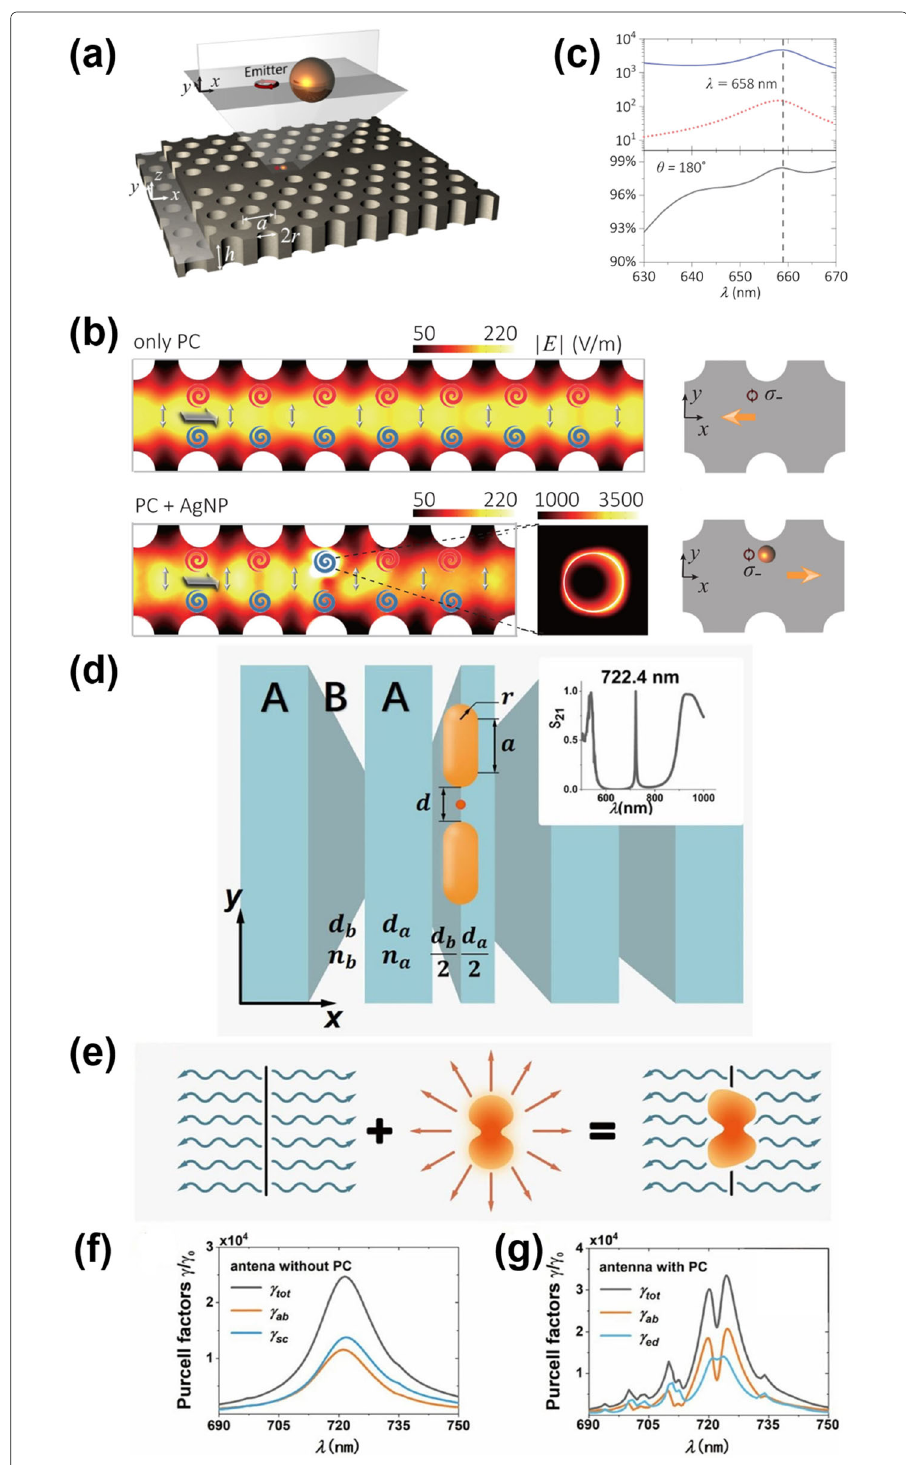
Fig. 11 Purcell effect in hybrid structures. a Schematic diagram of coupled structure consisting of PC and silver nanoparticle coupled to a chiral polarized emitter [148]. b Mechanism of spin-locked photonic propagation with chiral emitter [148]. c Purcell factors of structure ( a ) with high directionality [148]. d Schematic diagram of 1D topological structure including a silver nanoantenna and a quantum emitter [238]. e Mechanism of edge state-led mode coupling [238]. Purcell factors of the nanoantenna ( f ) without and ( g ) with topological structure